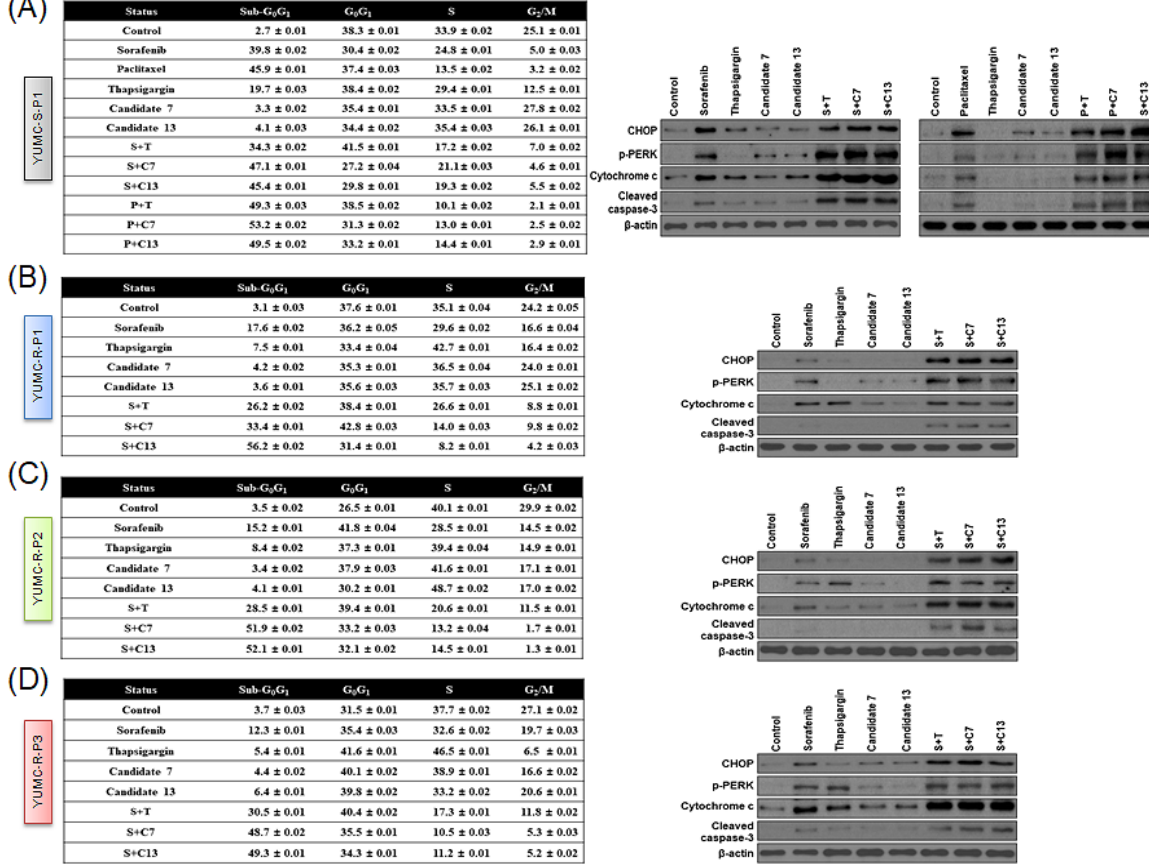
Figure 5. Level of apoptosis evaluated through quantitation of DNA content with propidium iodide and immunoblot analysis. Flow cytometry ( A – D , left ) and immunoblot analysis ( A – D , right ) of patient-derived antineoplastic-sensitive (YUMC-S-P1) and paclitaxel- or sorafenib-resistant PTC cells (YUMC-R-P1, -P2, and -P3). ( A – D , left ) Cells were exposed to the indicated SERCA inhibitors, paclitxel or sorafenib alone or in combination, harvested, and stained with propidium iodide before analysis by flow cytometry, using FlowJo version 8. ( A – D , right ), Immunoblot analysis—comparative levels of expression of CHOP (endoplasmic reticulum stress marker), cytochrome c , and cleaved caspase-3 (apoptosis-related marker) between antineoplastic-sensitive (YUMC-S-P1) and paclitaxel- or sorafenib-resistant PTC cells (YUMC-R-P1, -P2, and